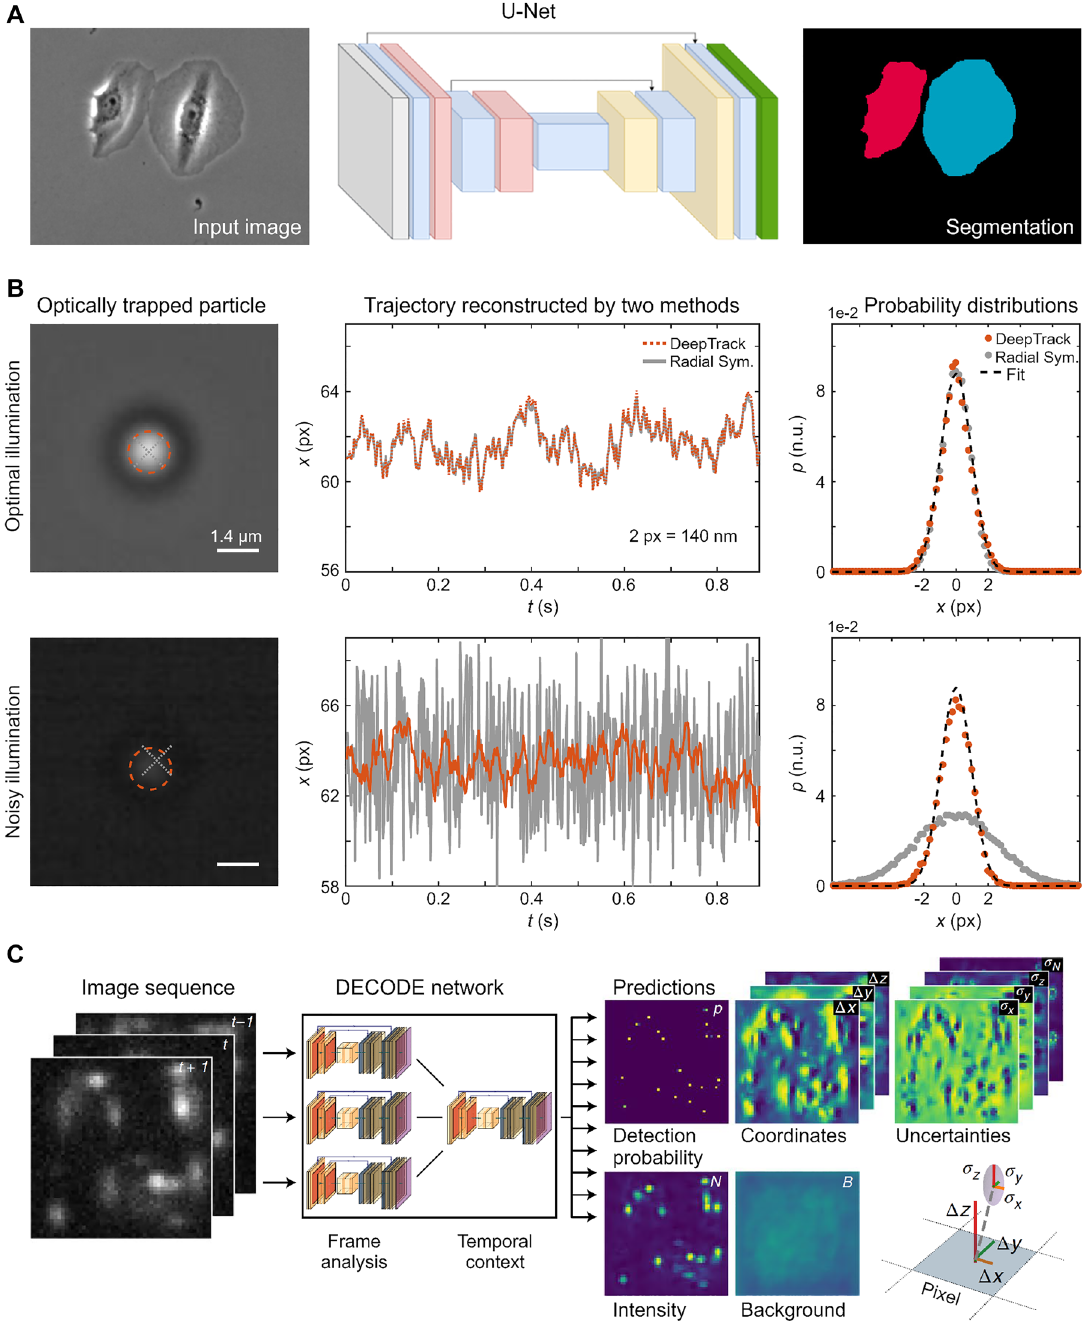
Figure 5: Image analysis by neural networks . A Pixel-wise classification to segment objects in microscopy images. The method is based on the U-Net architecture and outputs a binary image corresponding to cells (white) and background (black). B Particle localization using a CNN. The CNN is trained using simulated images of microscopic particles. The neural network outputs the position of a particle within a region of fixed size. This model (orange lines) outperforms traditional approaches (gray lines) in terms of accuracy, in particular for noisy images (lower panels). C Particle localization using a U-Net to identify the position and intensity of particles pixel by pixel. For each pixel, the network predicts the probability that an emitter exists near that pixel, the intensity of that pixel, the three-dimensional vector connecting the pixel to the closest emitter, as well as an estimate of the localization uncertainty. Panel A is reproduced with permission from Ref. [109] (Copyright 2019 Springer-Nature), panel B from Ref. [59] (Copyright 2019 Optica), and panel C from Ref. [111] (Copyright 2021